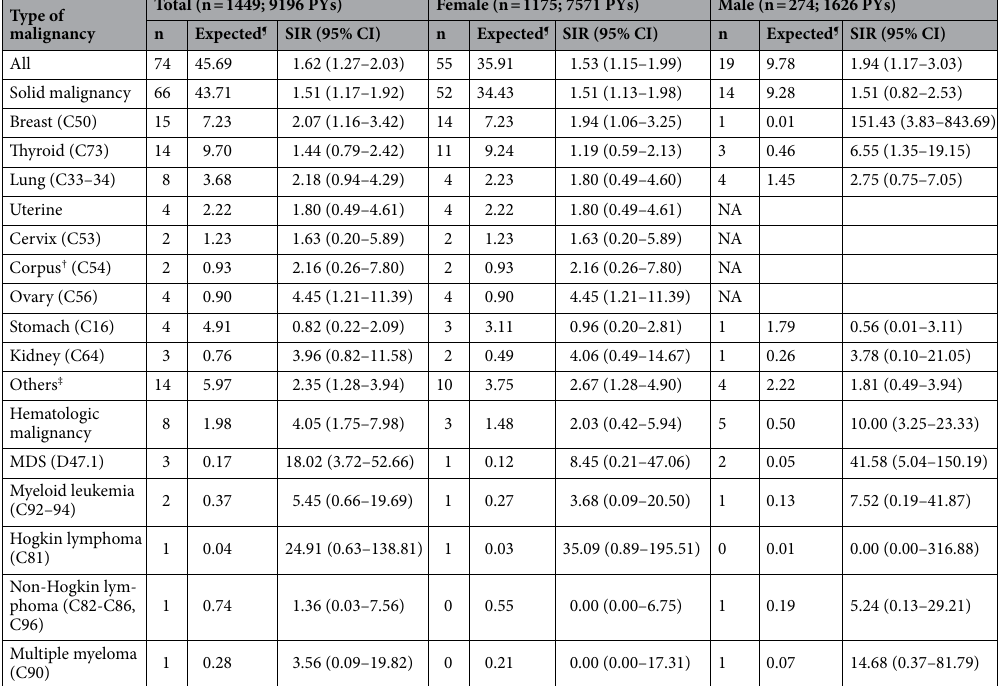
Table 2. Comparison of malignancy type and sex by number, expected incidence, and standardized incidence ratio compared with general population. ¶ Expected number of patients with malignancy calculated based on the incidence of malignancy in the age- and sex- matched general population. † Corpus uterine cancer includes malignancies in endometrium, myometrium, and fundus. ‡ CNS (C70–72), GB/CCC (C23–24), salivary gland (C07–08), liver (C22), connective tissue or soft tissue (C47, C49), oral cavity (C03–06), thymus, heart, or pleura (C37–38), non-melanoma skin cancer (C44), bladder (C67), esophagus (C15), and unspecified.